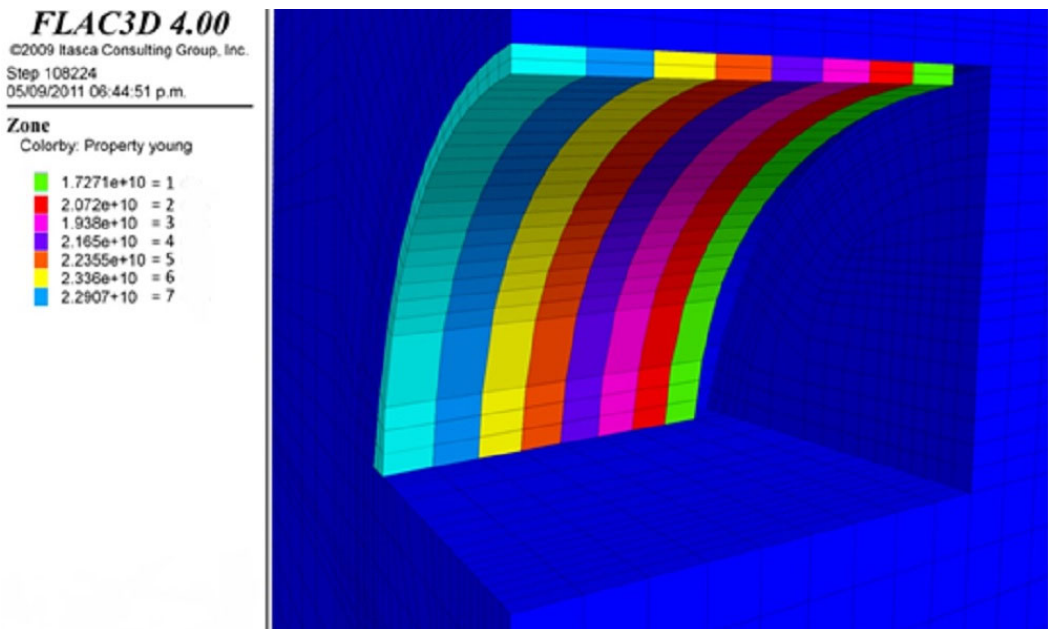
Figure 8. Ages and modulus of elasticity of shotcrete during the analysis [12] from day 1 (green) to the day 7 (blue).